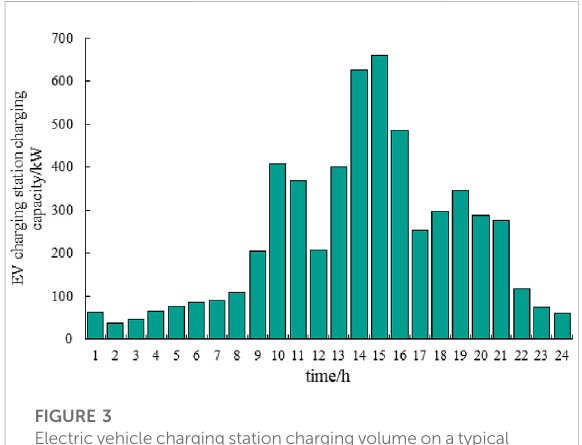
FIGURE 3 Electric vehiclecharging station charging volume onatypical summer